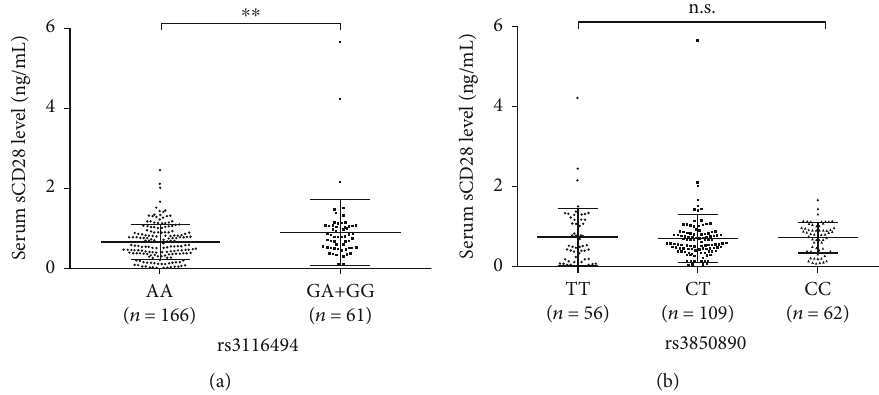
Figure 4: Association of CD28 -rs3116494 and CD80 -rs3850890 genotypes with serum sCD28 levels. (a) Comparison of serum sCD28 levels in CD28 -rs3116494 genotype groups; as percentage of subjects with the GG genotype was low, we combined individuals with the GA and the GG genotypes as one group. P values were determined using t -tests ( P = 0 : 0091 ). (b) Comparison of serum sCD28 levels in di ff erent CD80 - rs3850890 genotype groups. P values were determined by one-way ANOVAs ( P > 0 : 05 ). n.s. means not signi fi cant ( P > 0 : 05 ); ∗∗ P < 0 : 01